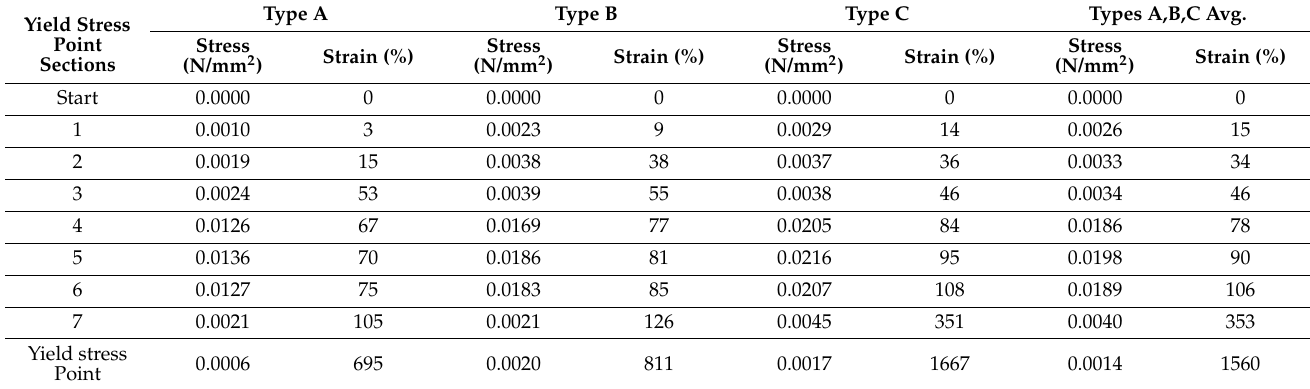
Table 6. Average stress yield derived